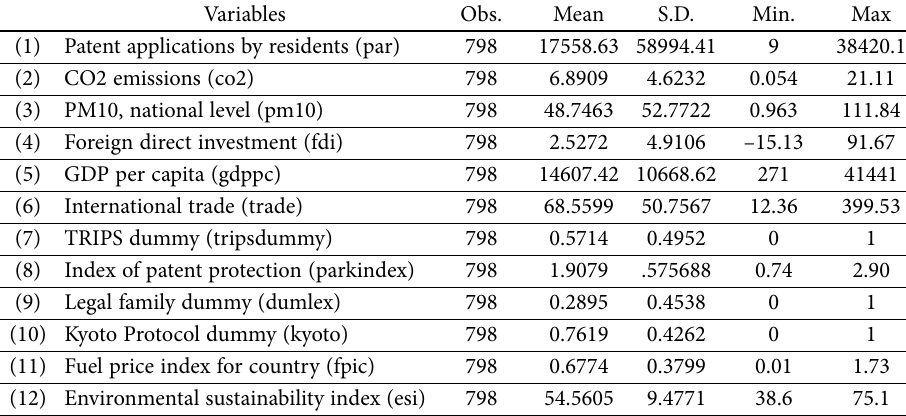
Table 3. Summary of